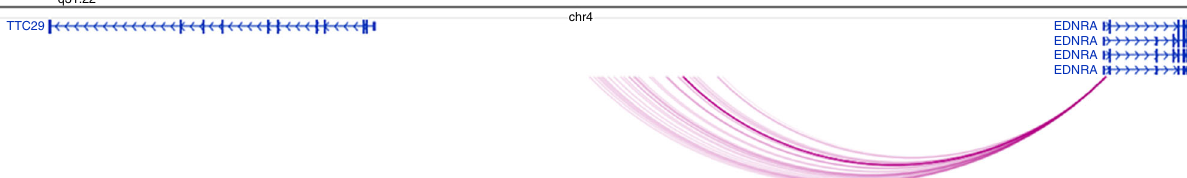
Fig. 2 Enrichment of cardiac VISTA enhancers in cPIRs. a Percentages of cPIRs or hESC PIRs overlapping with VISTA enhancers of the heart, branchial arch and limb. Results obtained with randomised PIRs (1000 permutations) are shown as controls. The p values were generated from permutation tests performed to compare observed vs. randomised PIRs and corrected for multiple testing using Bonferroni procedure. b Image of mm172-reporter staining of an E11.5 mouse embryo obtained from the VISTA enhancer browser (https://enhancer.lbl.gov/) 14 . c Promoter – cPIR interactions of hESC-CM occurring between the promoters of TTC29 and EDNRA (thick arc line represents the interaction between EDNRA ’ s promoter and mm172). d PCR using gDNA/cDNA to detect mm172 deletion/ Ednra expression and immunoblotting to detect EDNRA (glycosylated) were performed to compare rat cardiomyoblast H9c2 cell lines transfected with the empty plentiCRISPRv2 plasmid or the same plasmid cloned with two gRNA sequences to target mm172. Actb /ACTB is the loading